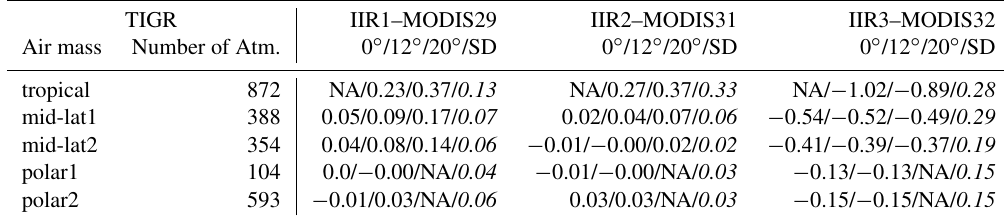
Table 3. Simulated brightness temperature difference (TIGR_BTD) in Kelvin between IIR and MODIS/Aqua companion channels for MODIS viewing angles of 0, 12, and 20 ◦ , whenever relevant (NA if not), and standard deviation (in italic) for five air mass types from the TIGR data